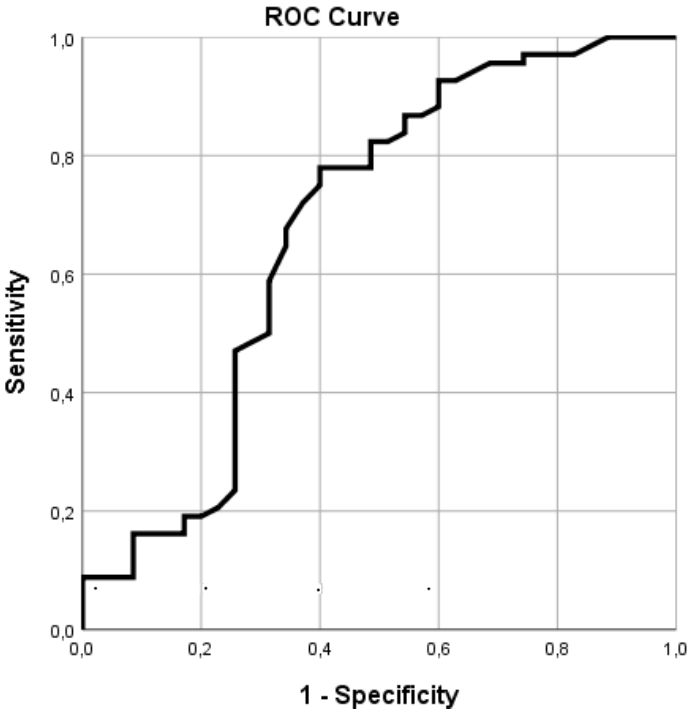
Figure 2. ROC-curve photo-optical TCpO2. Receiver operating characteristic (ROC)-curve of transcutaneous oxygen tension measurement (TCpO2) and wound healing.